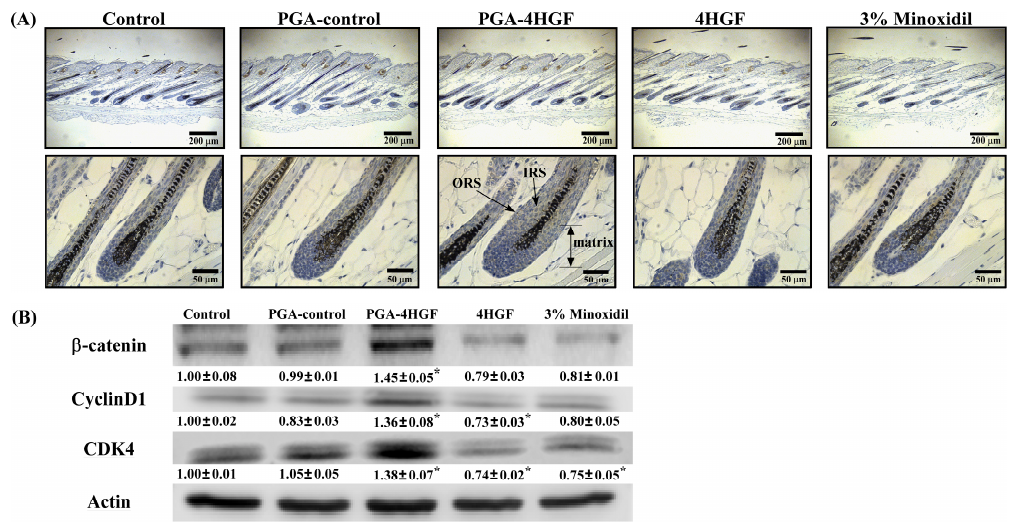
Figure 6. Induction of β -catenin and cell cycle-associated protein expression by PGA-4HGF in telogenic C57BL/6N mice. ( A ) Representative photomicrograph of the hair follicles in skin tissue treated with PGA-control, PGA-4HGF, or 4HGF, on day 12 (200 and 400× magnification, scale bars: 200 and 50 μ m, respectively). ( B ) β -catenin, cyclinD1, and CDK4 protein expression levels in mice dorsal skin, detected using western blotting. Values data represent means ± standard error (SE). Data